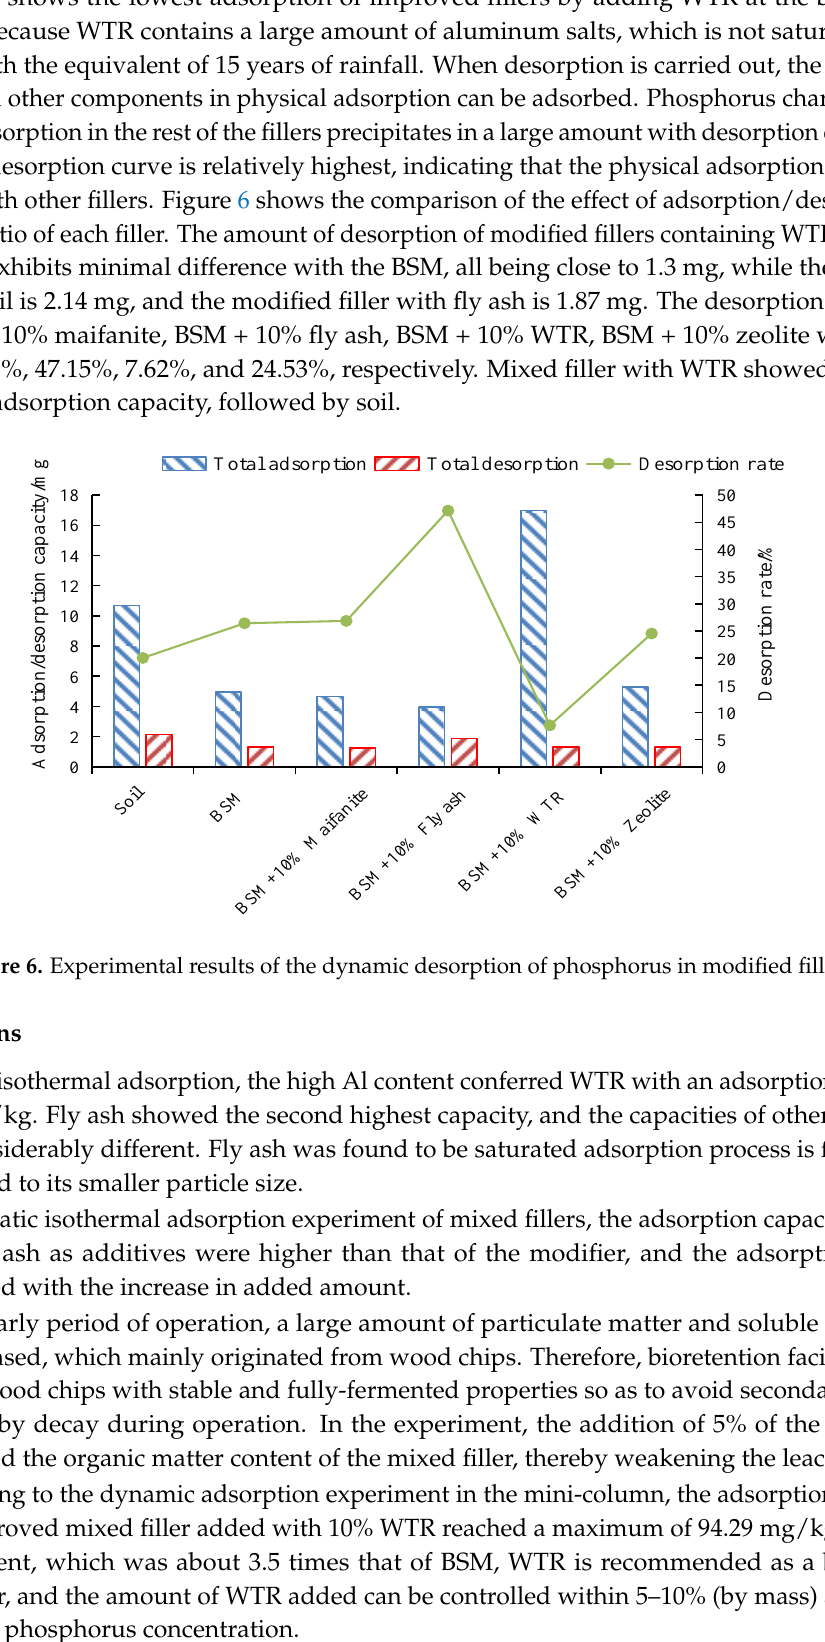
Figure 5. Dynamic desorption curve of phosphorus in modified fillers.